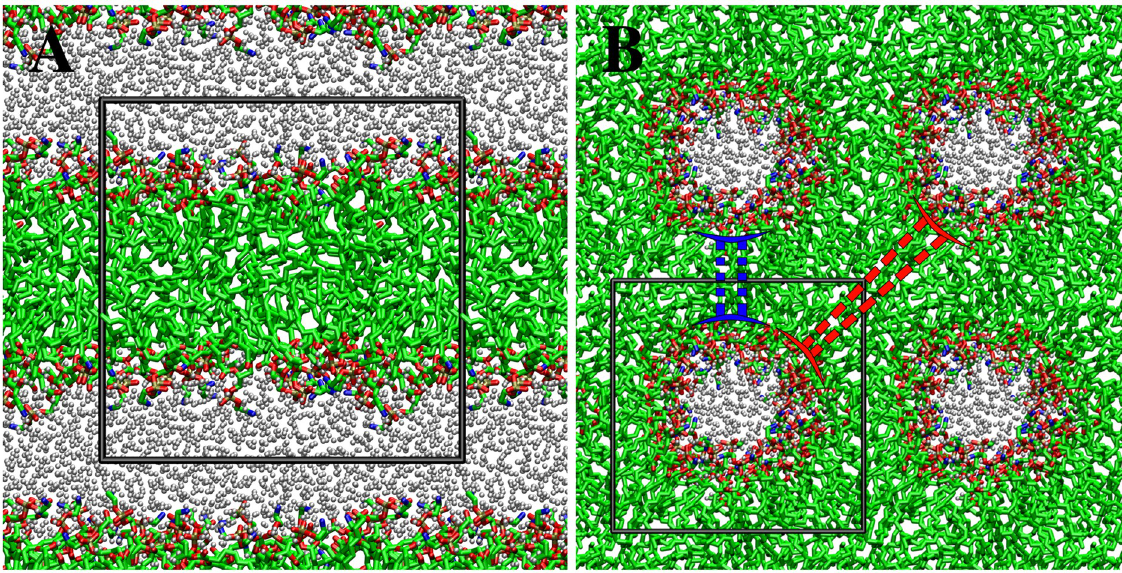
Fig 2. Structures obtained from the atomistic simulation of LC and HC states. (A) bilayer structure of the LC state. (B) pseudo-inverted hexagonal structure of the HC state. The blue and red dashed lines indicate lamellar and non-lamellar structural features respectively. Hydrogen atoms are not